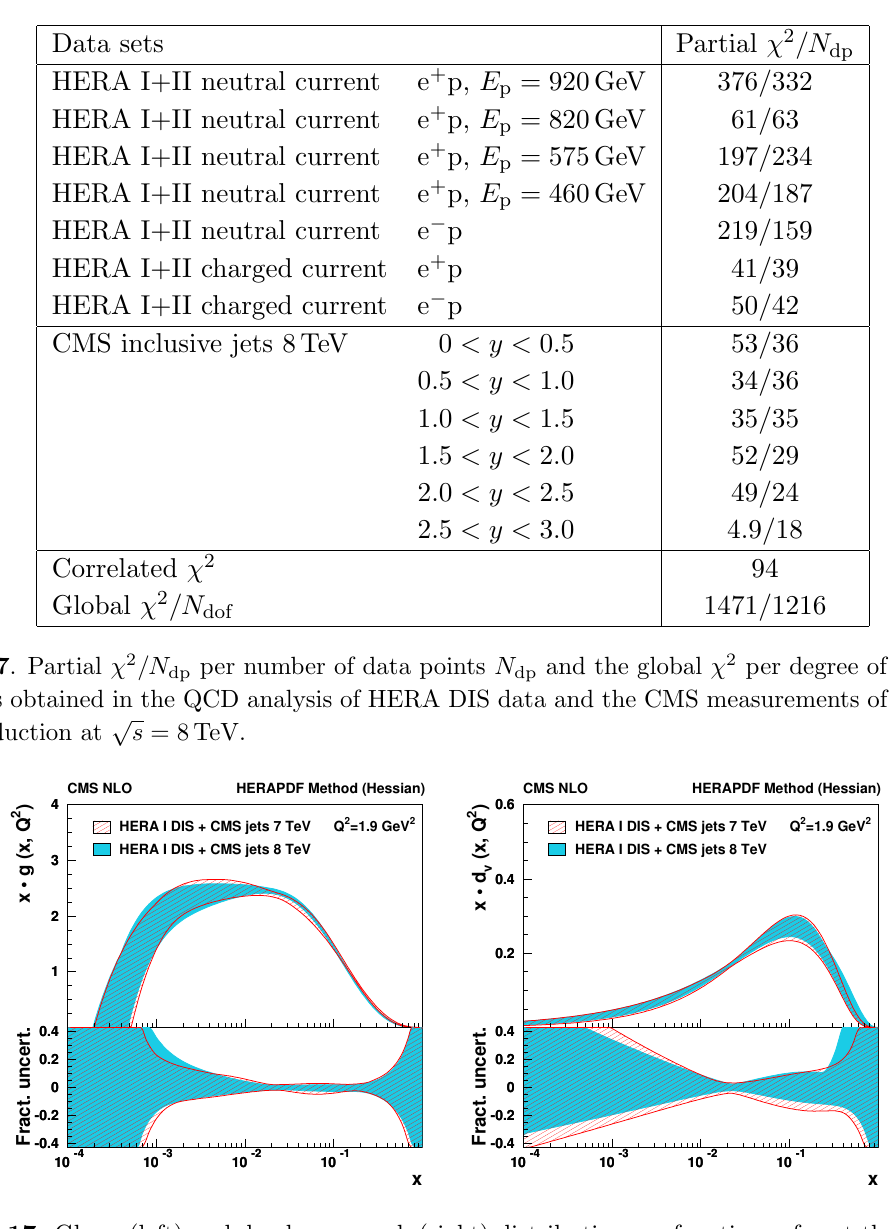
Figure 17 . Gluon (left) and d-valence quark (right) distributions as functions of x at the starting scale Q 2 = 1 : 9 GeV 2 . The results of the 13-parameter (cid:12)t [29] to the subset [40] of the combined HERA data and inclusive jet measurements at 7 TeV (hatched band), and, alternatively, 8 TeV (shaded band) are compared with their total uncertainties, as determined by using the HERAPDF method. In the bottom panels the fractional uncertainties are